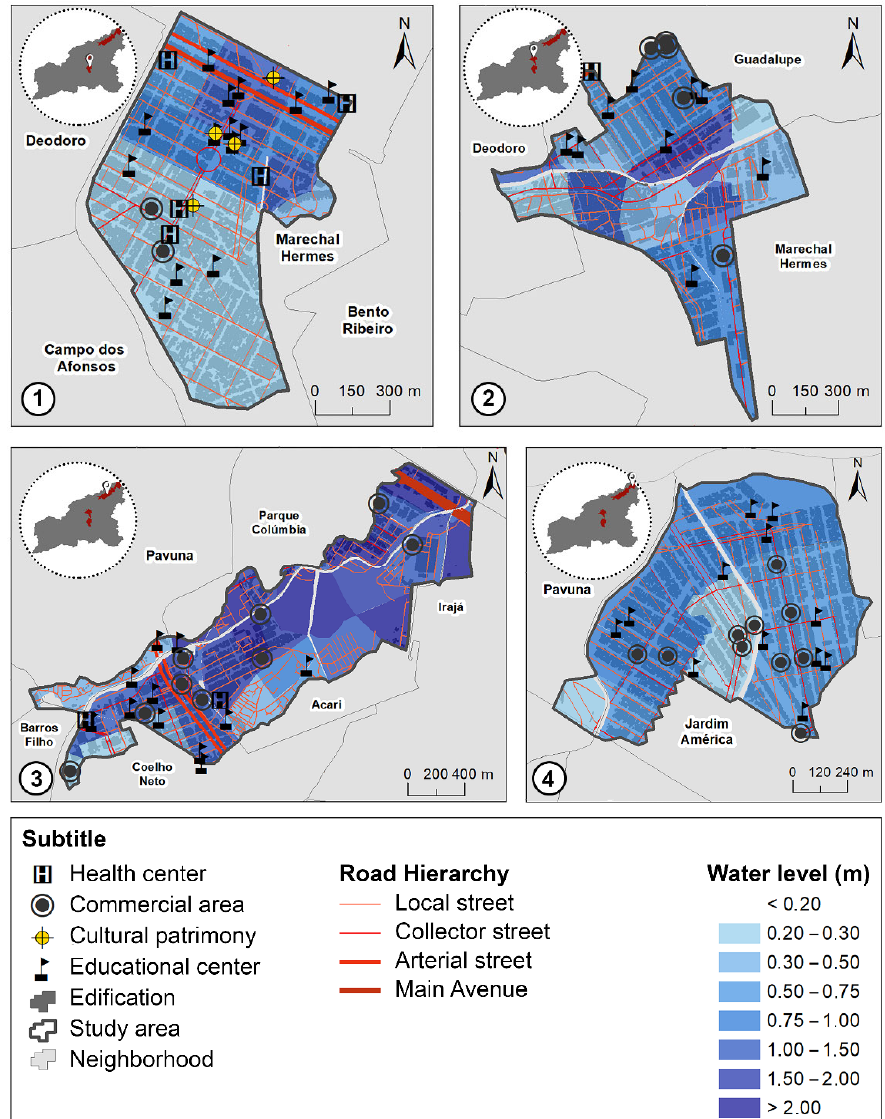
Figure 6. Summary maps of the analysis areas—Current Situation.